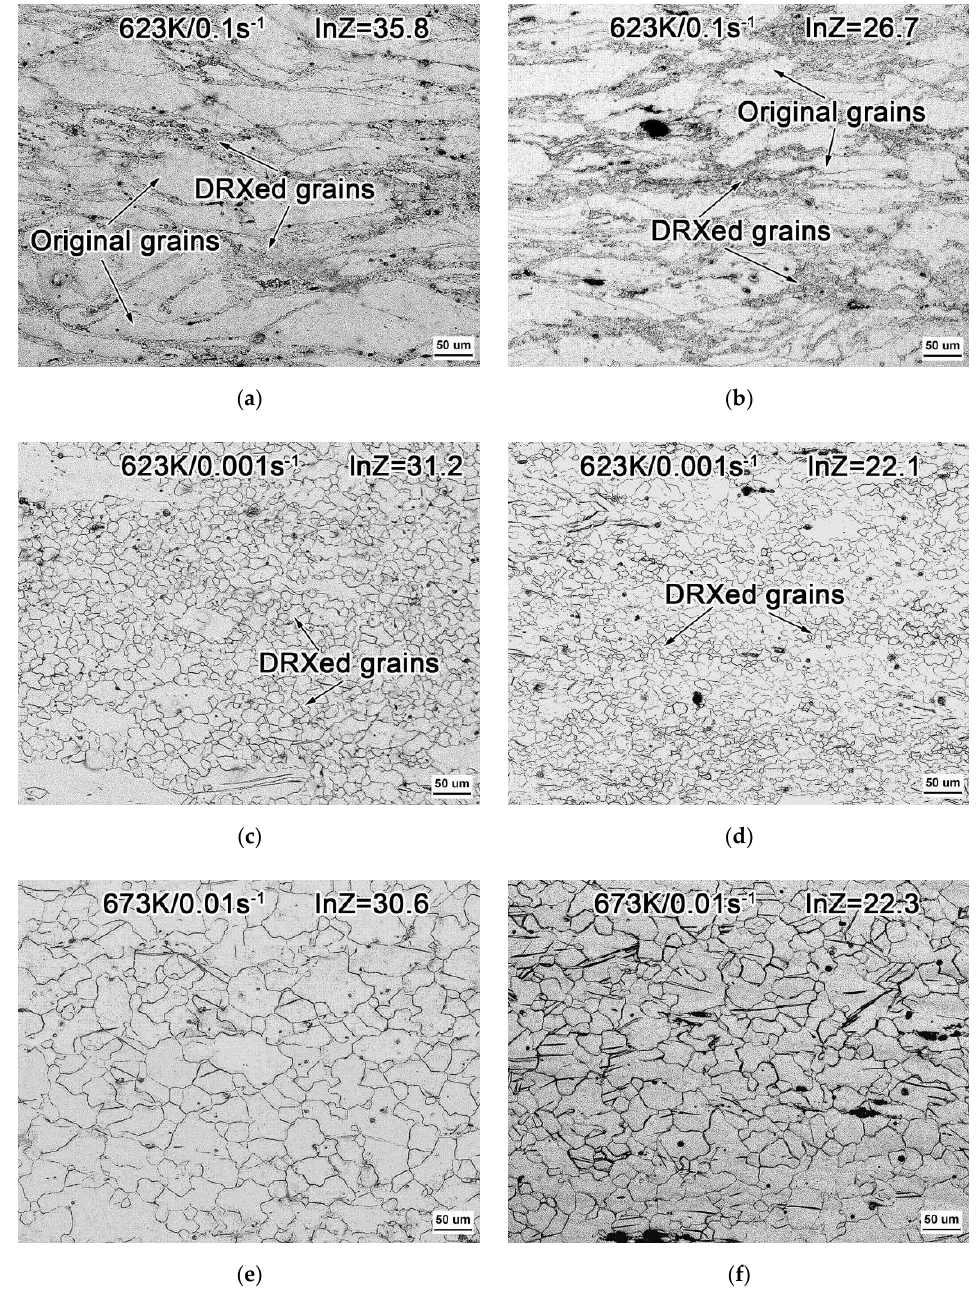
Figure 14. Microstructures of MZC ( a , c , e ) and MZCM ( b , d , f ) deformed at ( a,b ) 623 K/0.1 s − 1 , ( c,d ) 623 K/0.001 s − 1 and ( e,f ) 673 K/0.01 s − 1 .